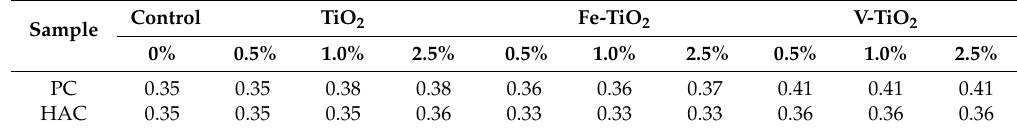
Table 3. Water demand of different samples expressed as water/cement ratios.